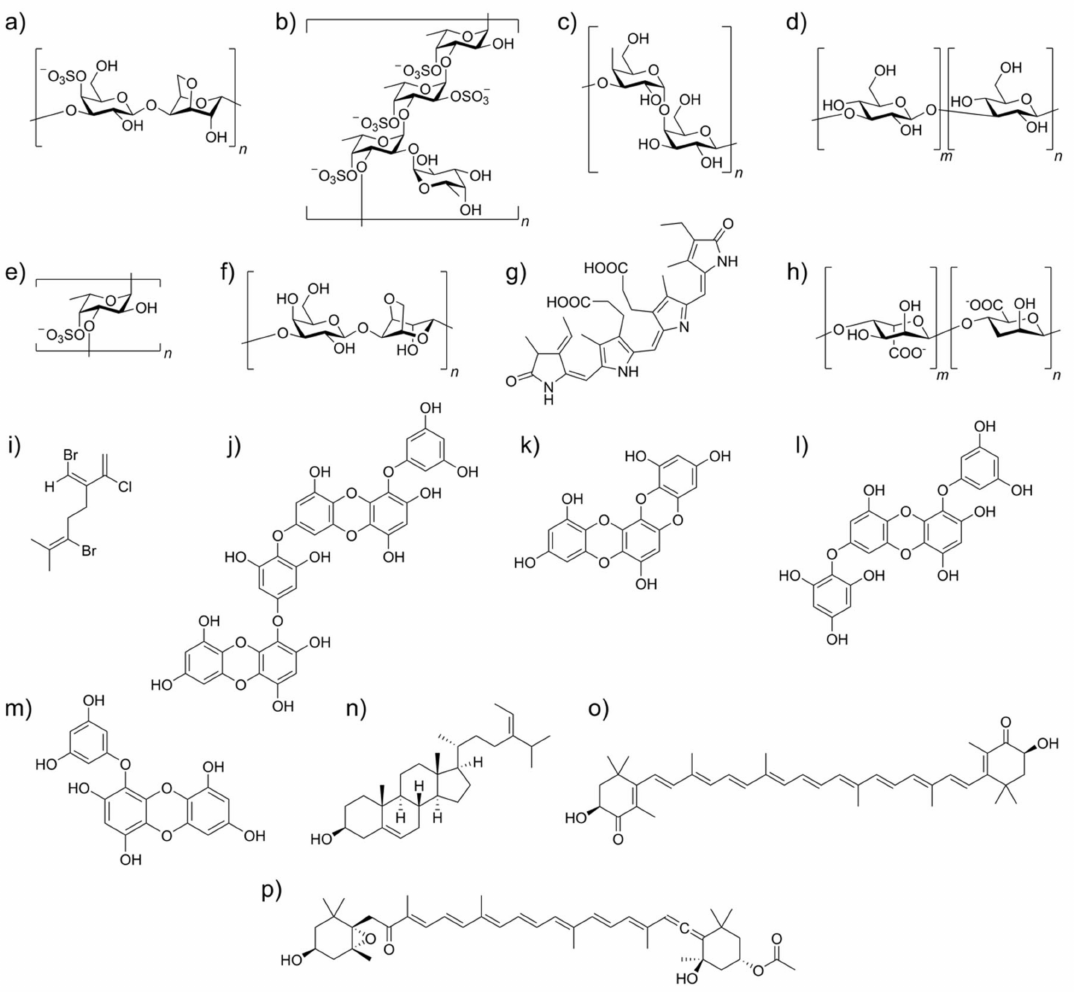
Figure 3. Molecular structures of algae-derived bioactive metabolites which can modulate viral inhibition and act as immunomodulators: ( a ) κ -carrageenan; ( b ) a fucoidan from Laminaria saccharina ; ( c ) galactan; ( d ) laminaran; ( e ) a sulfated fucan; ( f ) agar; ( g ) C-phycocyanin; ( h ) alginate; ( i ) a halo- genated monoterpene; ( j ) diecol; ( k ) dioxinodehydroeckol; ( l ) 7-phloroeckol; ( m ) eckol; ( n ) fucosterol; ( o ) astaxanthin; ( p )